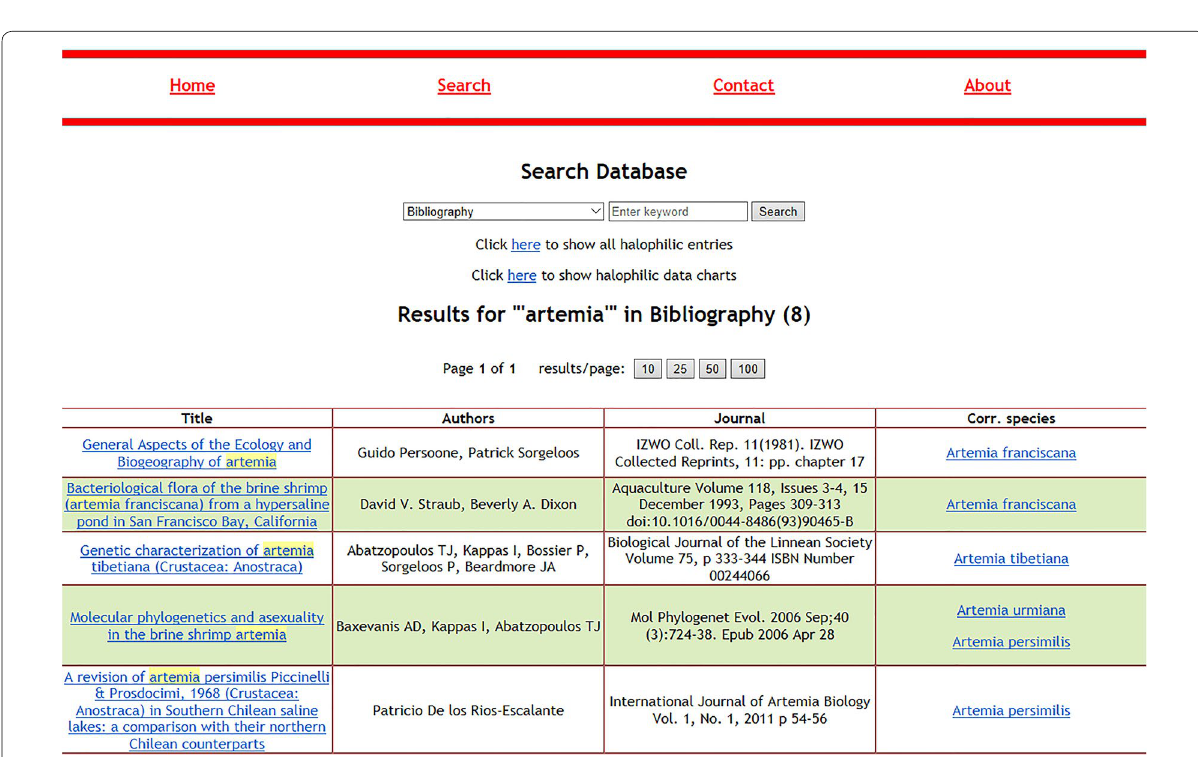
Fig. 4 The displaying format of “Bibliography” field results for the keyword